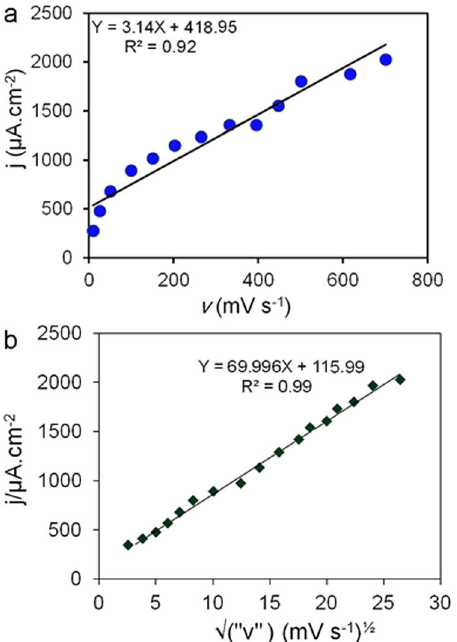
Figure 3: The plots of ( a ) scan rate and ( b ) peak current versus scan rate ½.